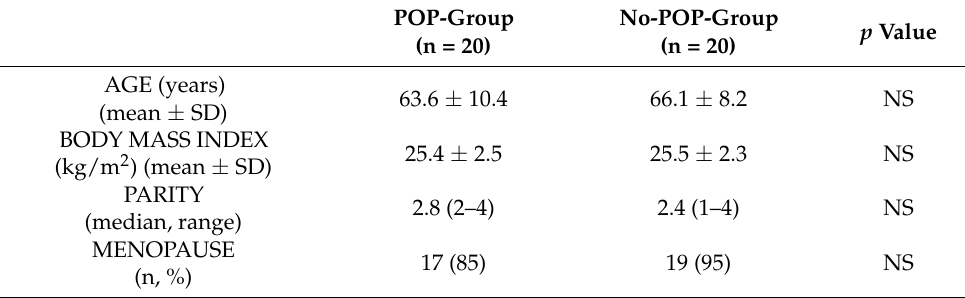
Table 1. Clinical characteristics of women with and without uterine